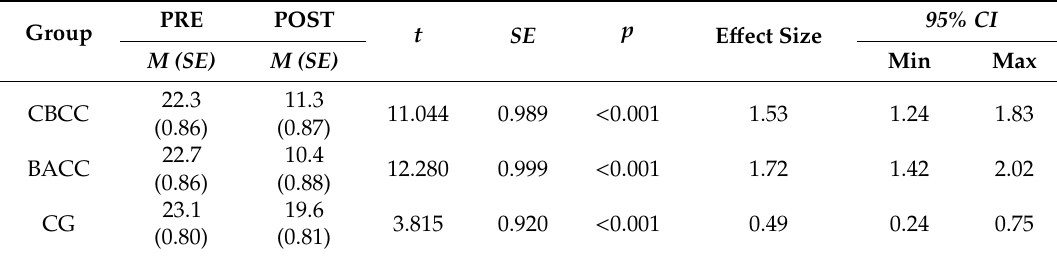
Table 2. Estimated marginal means, standard errors, and pre-post comparison on depressive symptomatology (CES-D) per group.